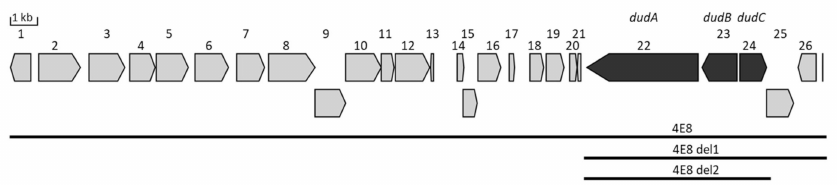
Figure 4. The chromosomal fragment of Streptomyces albus ssp. Chlorinus NRRL B-24108 containing the dudomycin gene cluster. The genes putatively involved in dudomycin biosynthesis are highlighted in dark grey. The chromosomal fragments cloned in BACs 4E8, 4E8_del1 and 4E8_del2 are shown with black